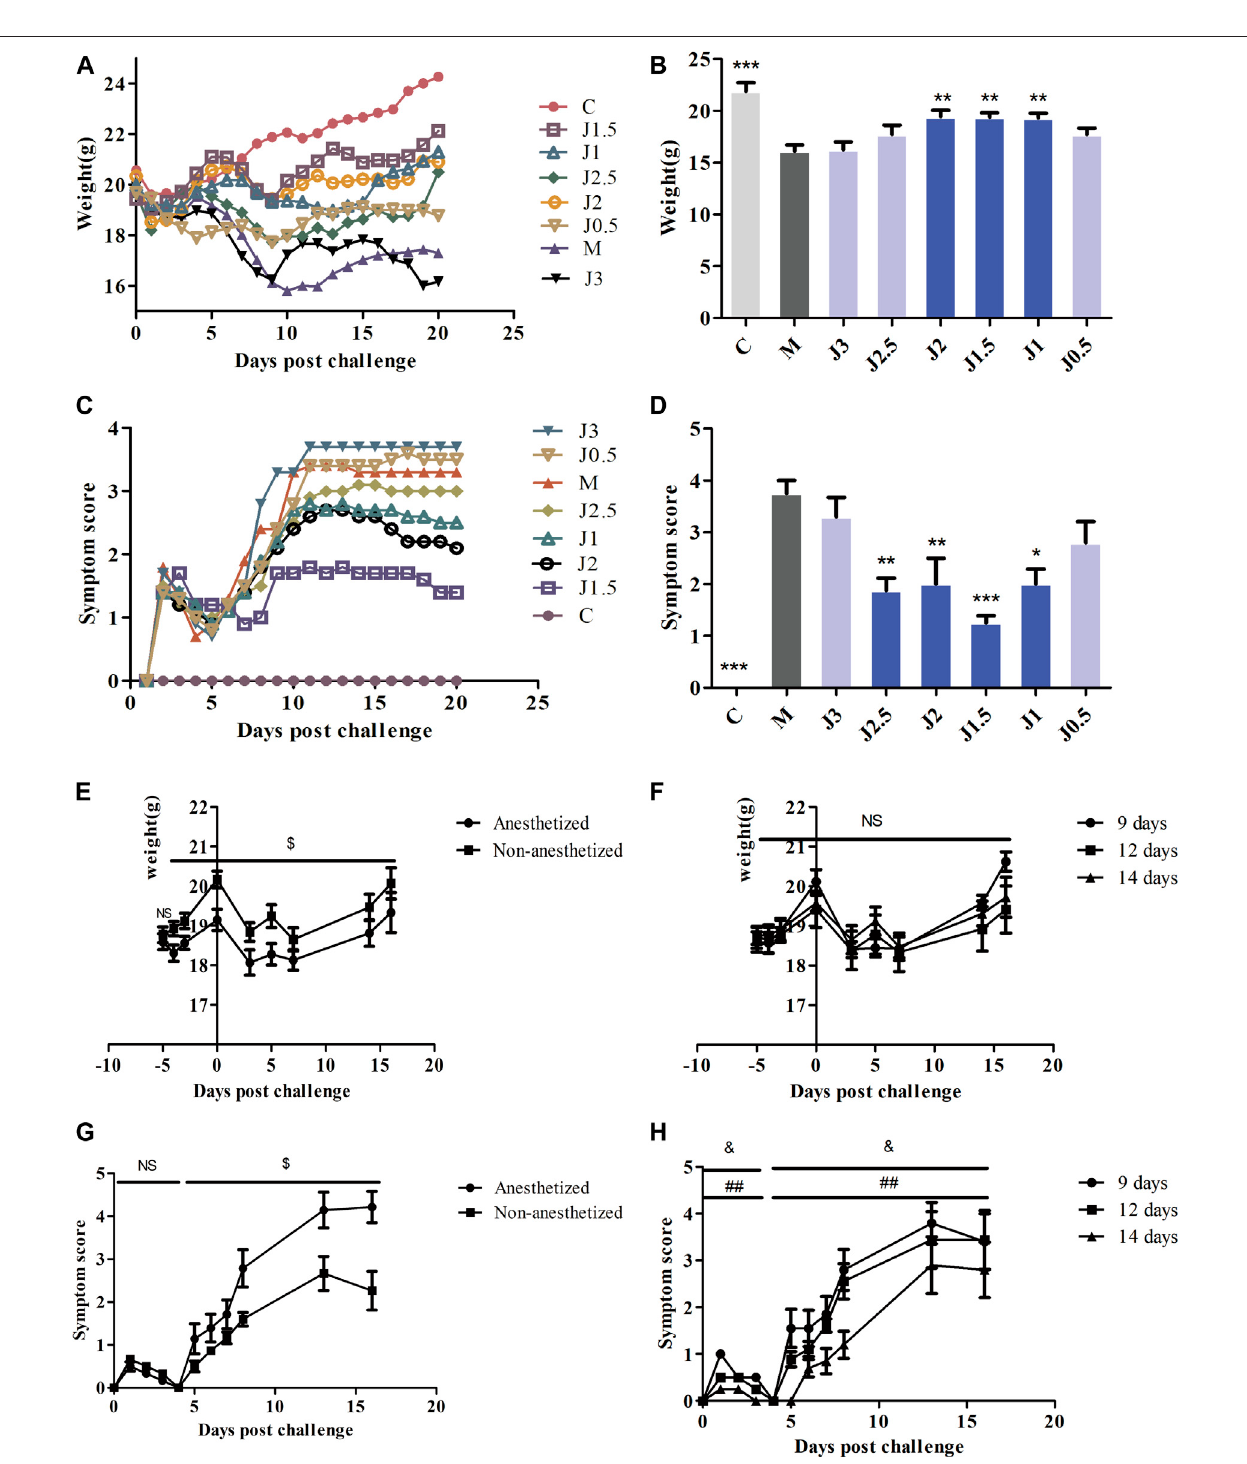
FIGURE 5 | Exploration of the effective concentration and administration mode of JZ-1. The effect of different concentrations JZ-1 on body weight (A, B) and symptomscore (C,D) ofGHmicewasexplored fi rstly,andthedataof (B,D) wasfromday9.Then,theeffectofanesthesiaandJZ-1administrationdaysonbodyweight (E, F) and symptom score (G,H) ofGHmice wasexplored.C:controlgroup, M:modelgroup. J3,J2.5,J2,J1.5,J1,J0.5:3,2.5, 2,1.5,1,0.5 g/mlJZ-1group. 14,12, 9 days:drugadministrationfor5,3,0 daysbeforemodelingplus9 daysaftermodeling. *p ＜ 0.05, **p ＜ 0.01, ***p ＜ 0.001 vs .Mgroup,$ p ＜ 0.05(Anesthetized vs . Non-anesthetized), & p ＜ 0.05 (14 days vs . 12 days), ## p ＜ 0.01 (14 days vs . 9 days).